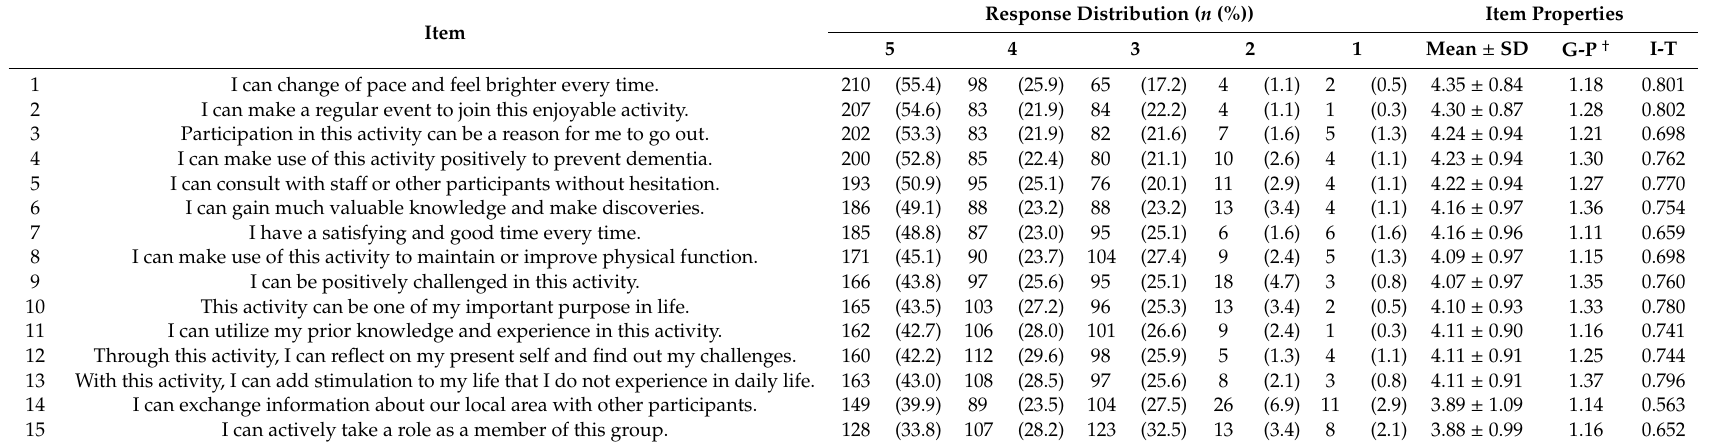
Table 2. Response distribution and properties of MPCPGA items ( n =